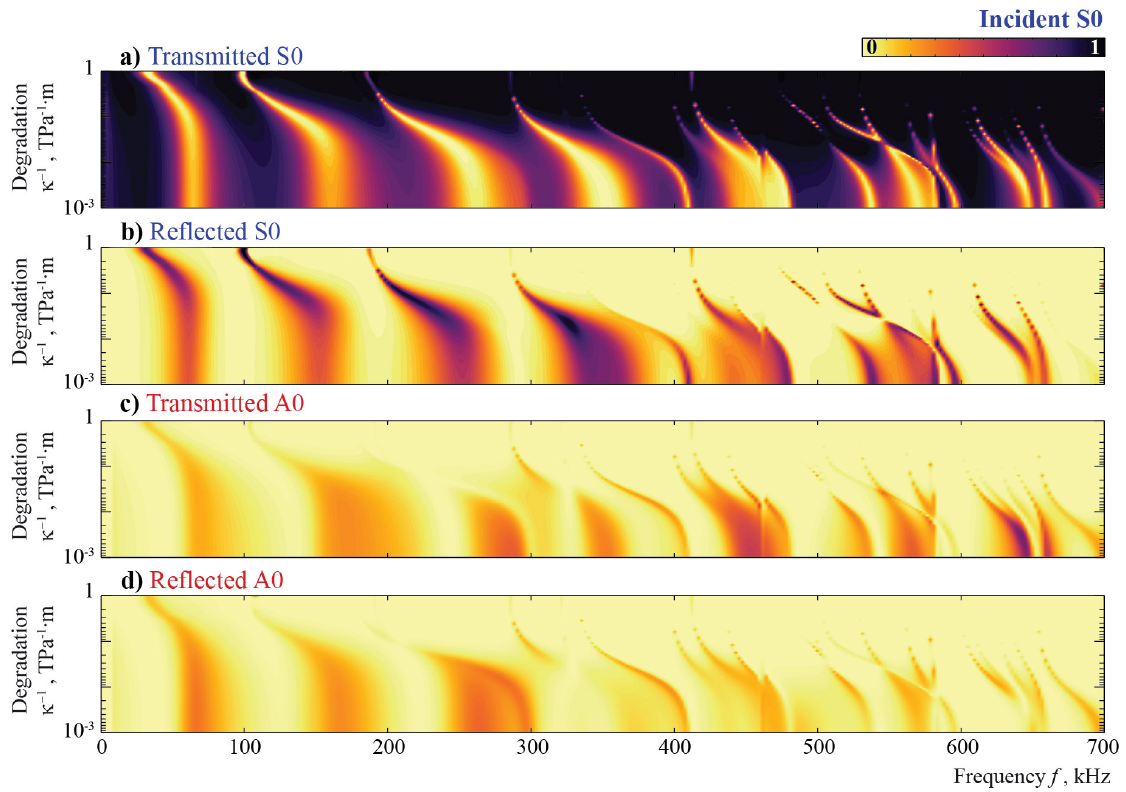
Figure 15. The transmission and reflection coefficients β ± m ( f , κ − 1 ) for the incident S0 mode scattered by an obstacle with a